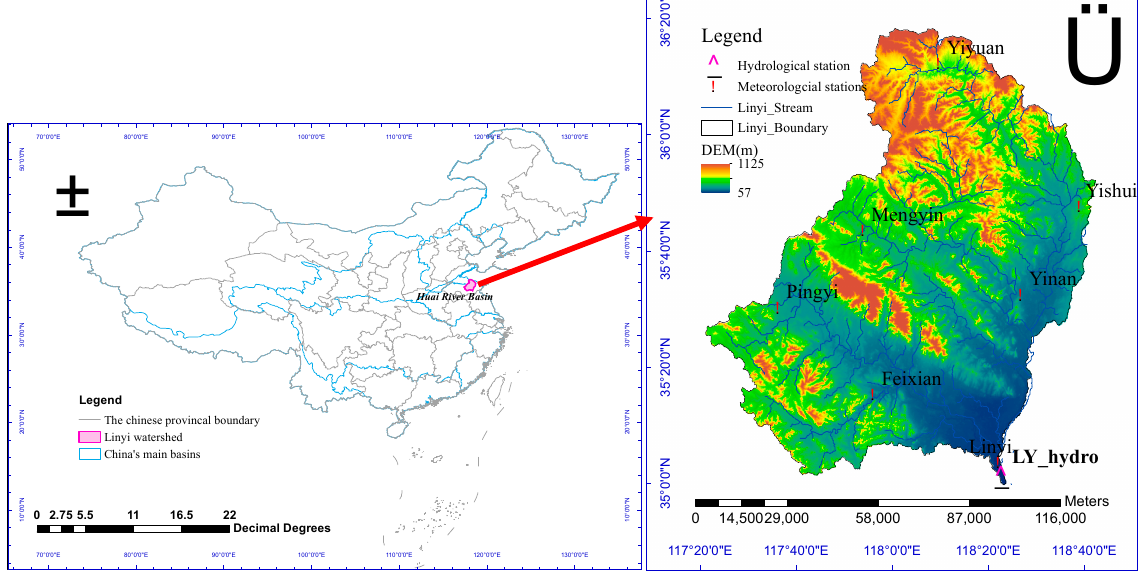
Figure 1. Spatial map of the Linyi watershed, and meteorological stations and hydrological control